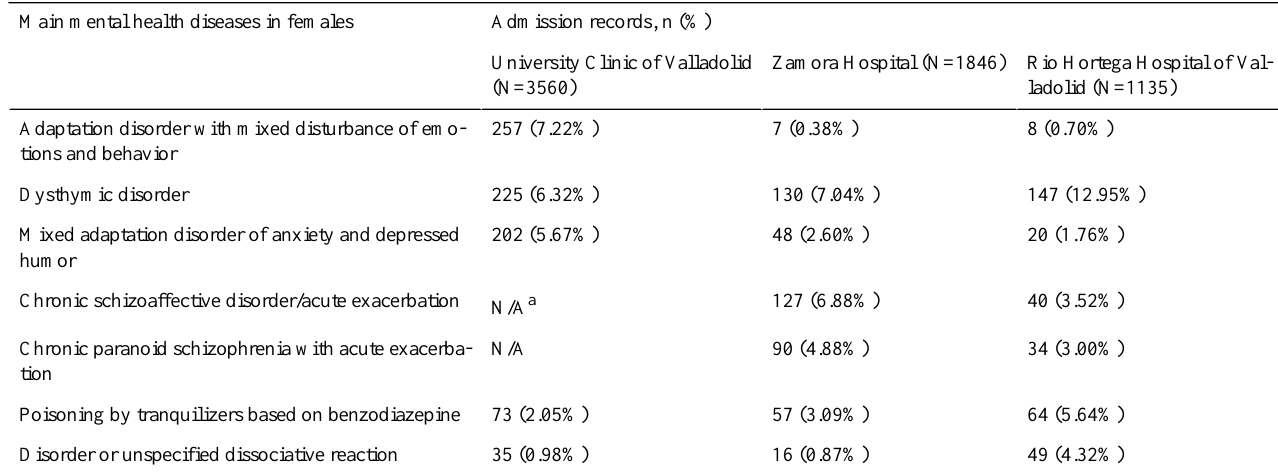
Table 3. Admission records according to mental health diseases in females for health care complexes in Valladolid and Zamora.